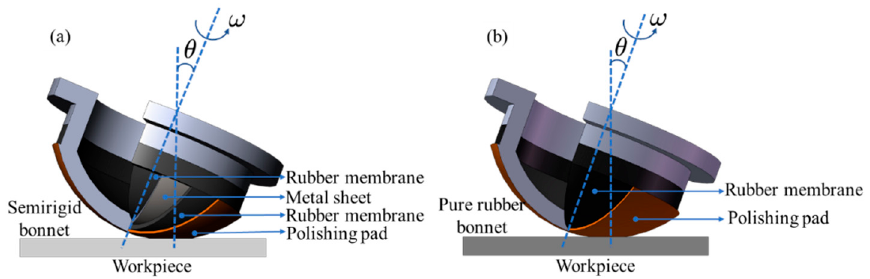
Figure 2. Structure of ( a ) the semirigid (SR) bonnet and ( b ) pure rubber (PR) bonnet.